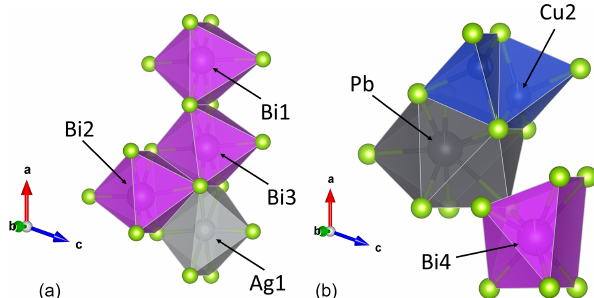
Figure 3. Morphologies of the coordination polyhedra in luxem- bourgite. (a) The Bi1, Bi2, Bi3, and Ag1 octahedra occur in the PbS-like pseudotetragonal layers. (b) The Pb [8], Bi4 [7], and Cu2 [3 + 1] sites occur between the pseudotetragonal and pseudohexag- onal anionic